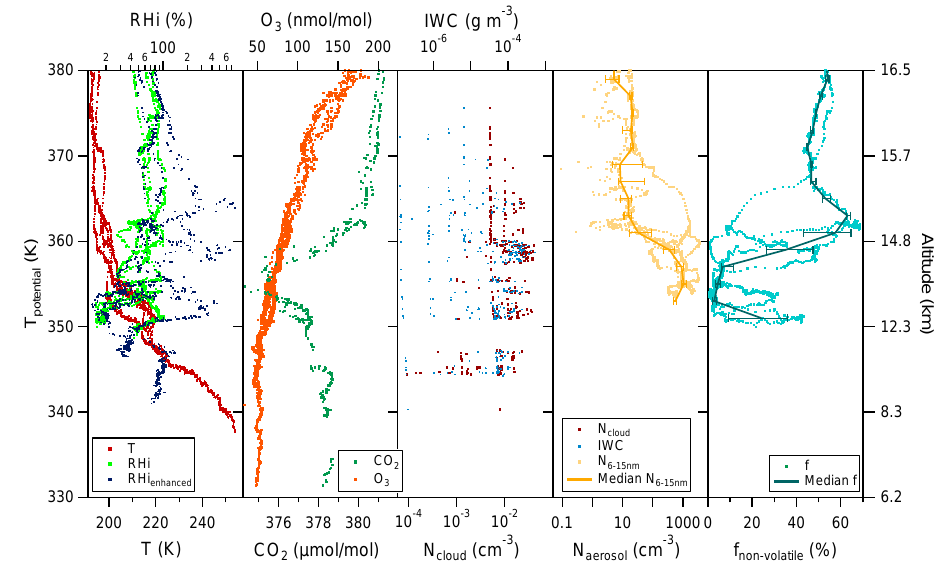
Fig. 8. Vertical profiles of the in situ measurements from the M-55 Geophysica flight on 11 August 2006 during selected flight segments. The error bars in the two rightmost panels denote the 33 and 67 percentiles. The deviations within the measured parameters are a result of the fact that these measurements comprise several ascents/descents including dives within the flight.